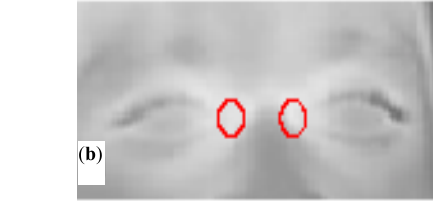
y = 0.982x + 0.5376 R² = 0.9941